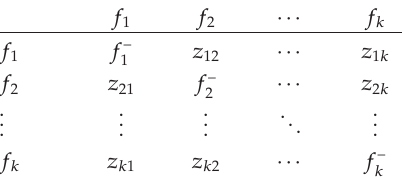
Table 2: Second pay-o ff